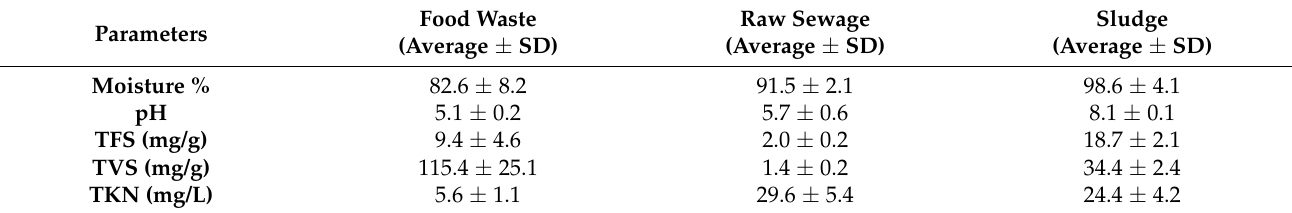
Table 1. Description of residues used in mixtures.